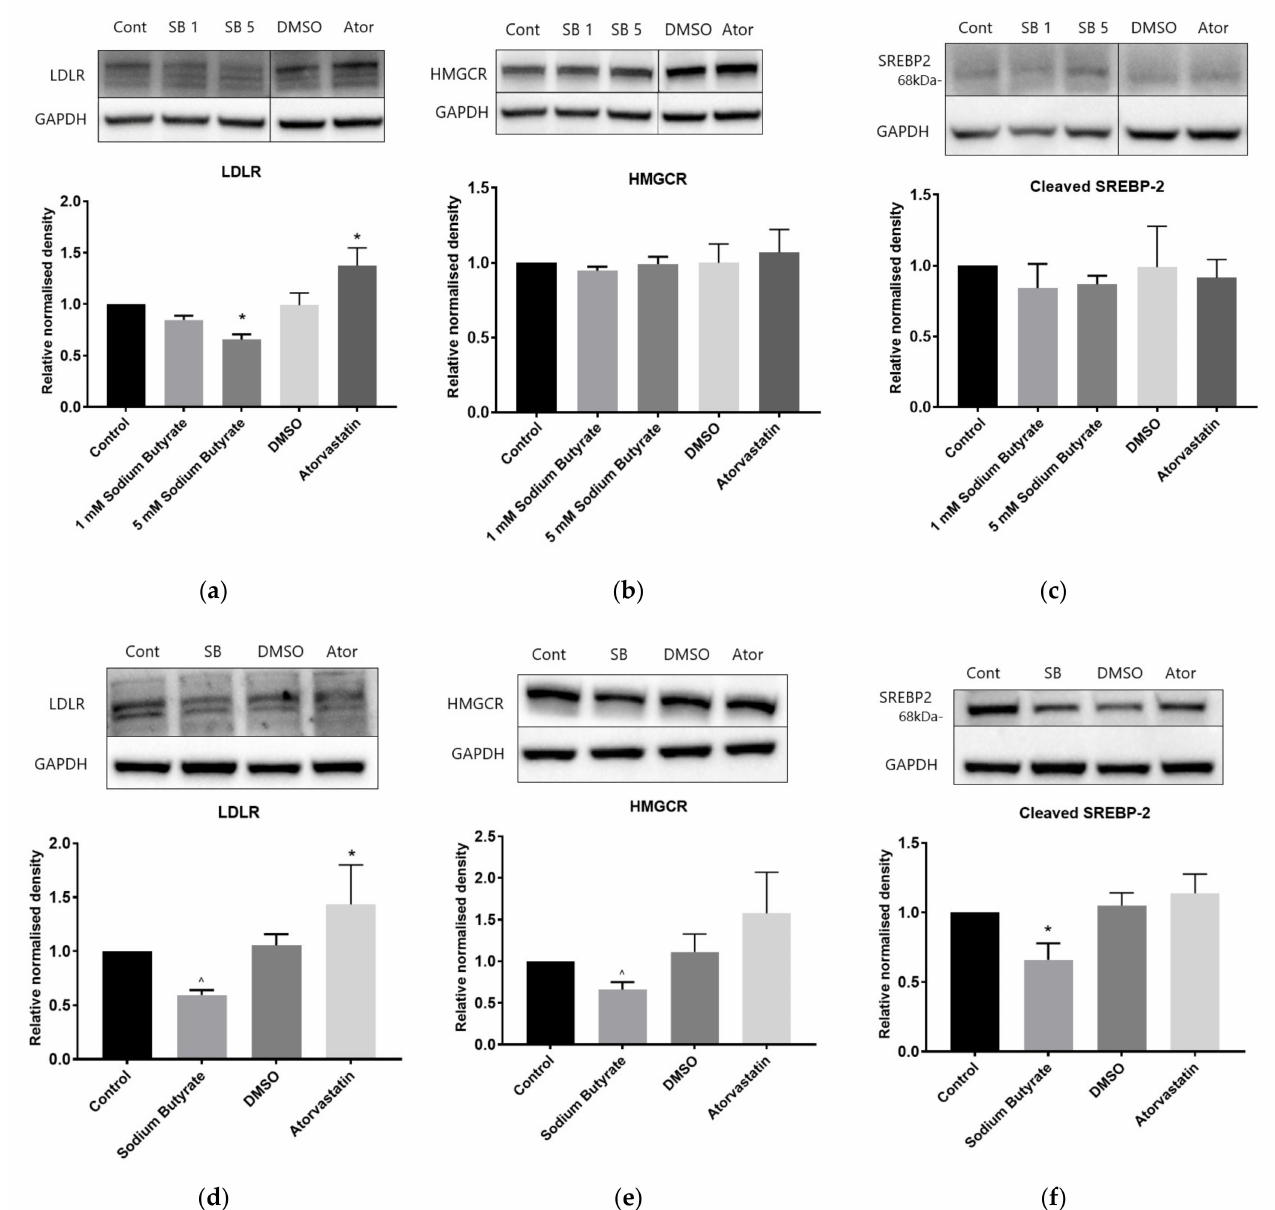
Figure 6. Atorvastatin and butyrate have differing effects on SREBP-2 signalling in HepG2 and THP-1 cells. In contrast to atorvastatin, 24 h treatment with sodium butyrate decreased rather than increased LDLR content in HepG2 and THP-1 cells. The 24 h treatment with butyrate also decreased HMGCR and cleaved SREBP-2 content in THP-1 cells, but not HepG2 cells. Immunoblots in HepG2 cells of ( a ) LDLR; ( b ) HMGCR; ( c ) cleaved SREBP-2; and in THP-1 cells of ( d ) LDLR ( e ) HMGCR; ( f ) cleaved SREBP-2. Cells were treated with 1 mM (SB1) or 5 mM (SB5) sodium butyrate (SB) or 10 µ M atorvastatin for 24 h. Control cells were treated with media only for butyrate and media containing DMSO for atorvastatin. The graphs represent the mean density readings as normalised to GAPDH from three independent experiments, with error bars representing SEMs. * p < 0.05 using ANOVA, ˆ p < 0.05 with two-tailed t test but not by